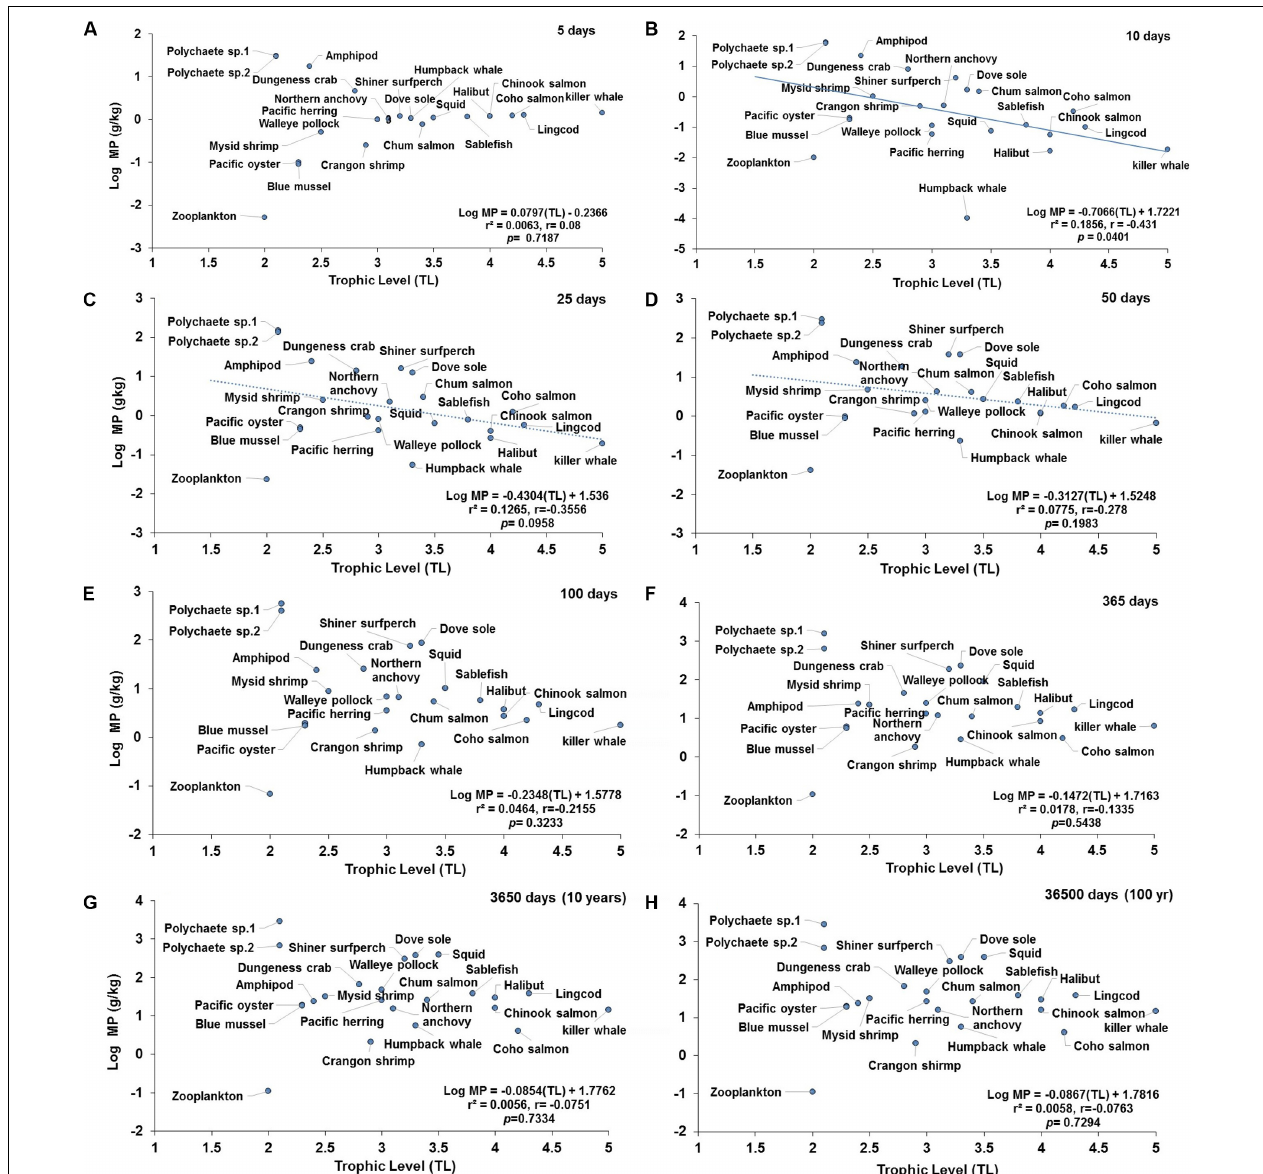
FIGURE 5 | Projections of the apparent trophic magnification factor (TMF) as a function of predicted concentration of microplastics (MPs) versus trophic levels (TL) in the cetaceans’ food web of the Northeastern Pacific for simulations under a scenario of high abiotic concentrations (scenario 3: seawater = [0.04 g/L]; and, sediment = [111 g/kg dw] at: (A) 5 days (the regression shows lack of significant relationship); (B) 10 days (regression line indicates a negative, significant relationship); (C) 25 days (dotted line indicates a negative trend but not a significant relationship; (D) 50 days (dotted line indicates a negative trend, but lack of significant relationship); (E) 100 days (dotted line indicates a negative trend, but lack of significant relationship); (F) 365 days or 1 year (lack of significant relationship); (G) 3650 days or 10 years (lack of significant relationship); and (H) 36500 days or 100 year (lack of significant relationship). For zooplankton, as the key trophic level for the initial uptake of MPs, a k E = 0.143/d (i.e., retention time = 7 days) was